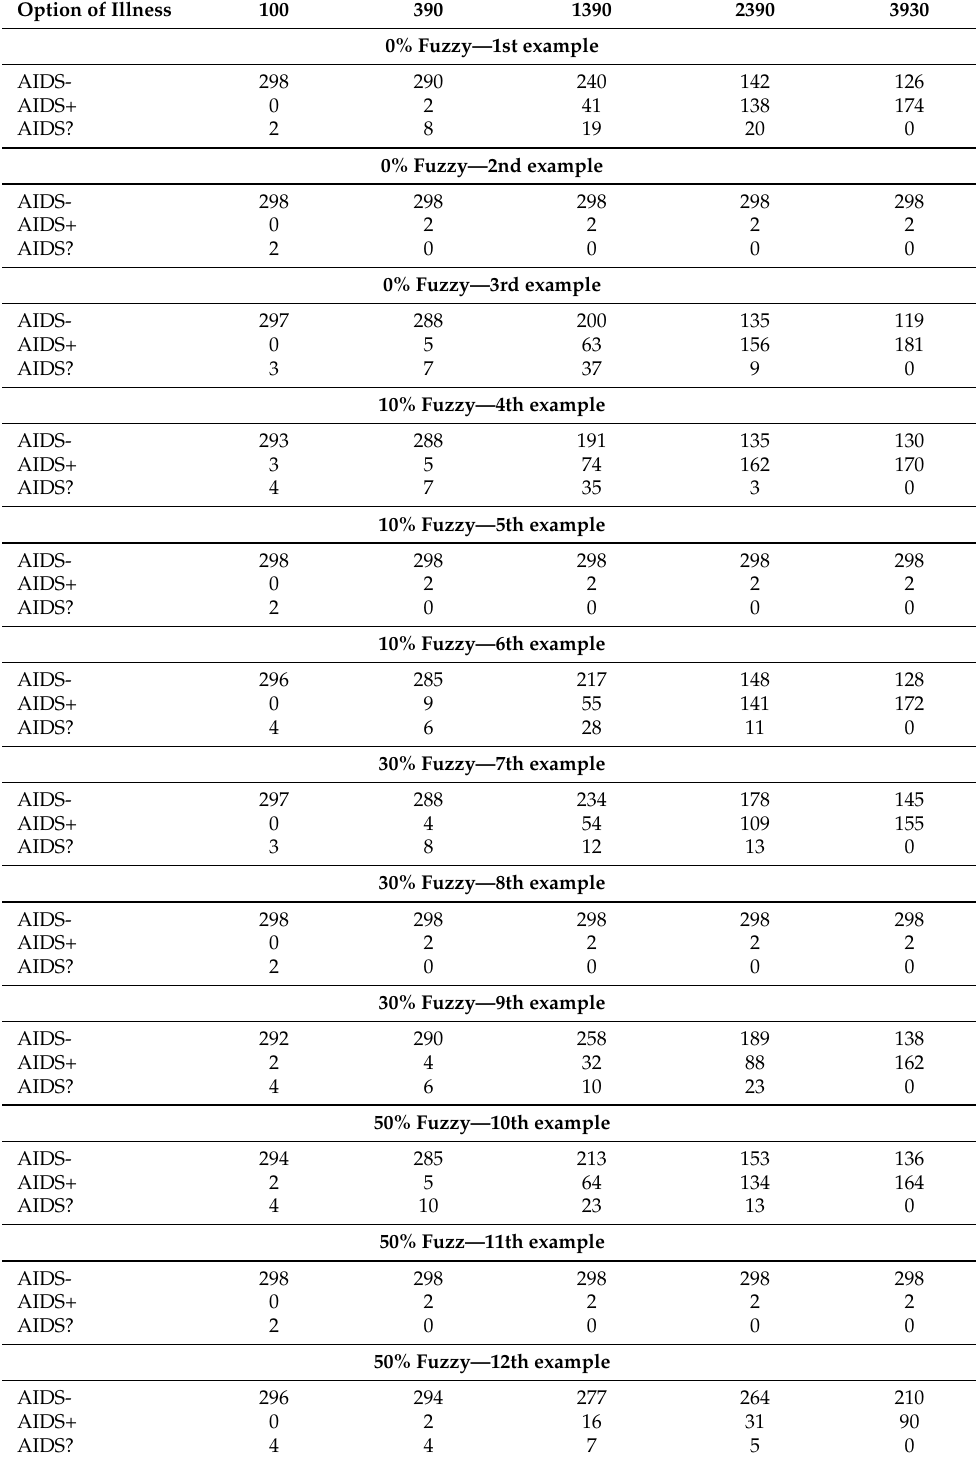
Table 4. People regarding the first scenario for a different number of